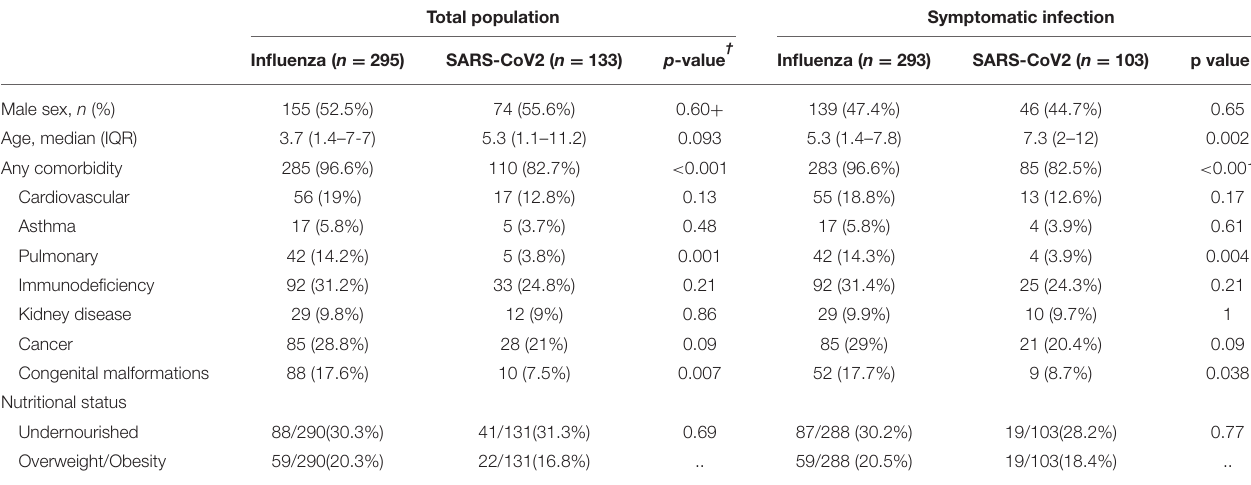
TABLE 1 | Baseline characteristics of patients with influenza and SARS-CoV2 infection.